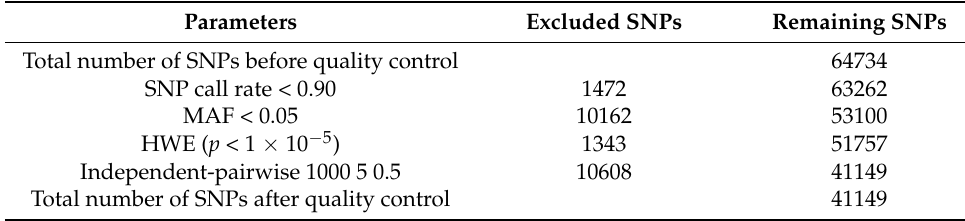
Table 1. Single nucleotide polymorphism chip marker-based quality filtering results.